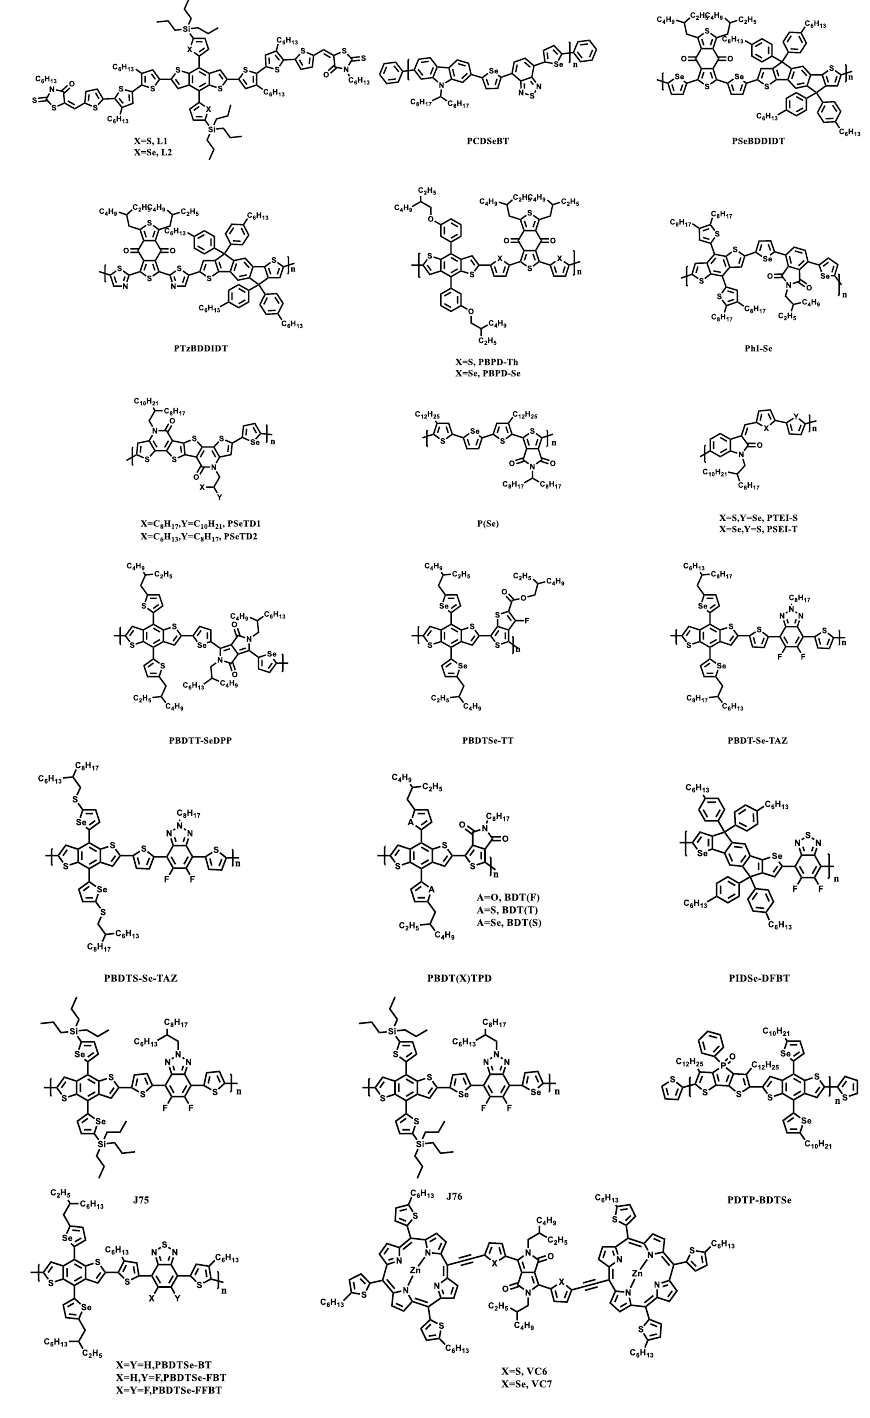
Figure 5. Donors substituted by